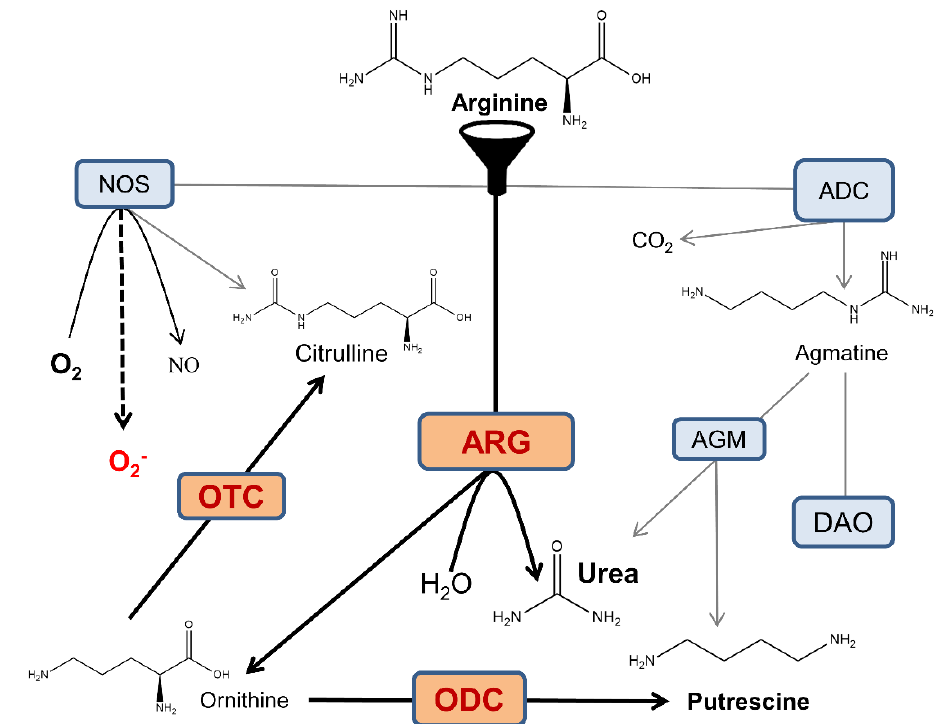
Figure 7. Crossroads of arginine metabolism in the AD brain. NOS oxidatively converts arginine into citrulline and NO. Arginase (ARG) hydrolyzes arginine into ornithine and urea. Arginine decarboxylase (ADC) produces agmatine and carbon dioxide via arginine decarboxylation. Agmatine is utilized in putrescine synthesis via agmatinase (AGM), and alternatively, the neurotransmitter GABA is synthesized in the diamine oxidase (DAO) pathway. Ornithine transcarbamylase (OTC) yields citrulline and phosphate. These pathways interfere with each other via intricate substrate competition mechanisms. For the sake of diagram simplicity, several intermediate steps and byproducts are omitted. In the AD brain, overactive arginase competes with NOS and ADC for the common substrate and reduces the bioavailability of arginine, which limits the production of agmatine and NO, and leads to NOS uncoupling and generation of superoxide anion. Overactivation of ornithine decarboxylase (ODC) leads to a surplus of downstream polyamine products, which can be neurotoxic [97]. Moreover, the gradual oxidation of polyamines by polyamine oxidase is associated with the generation of hydrogen peroxide and leads to oxidative stress [98].